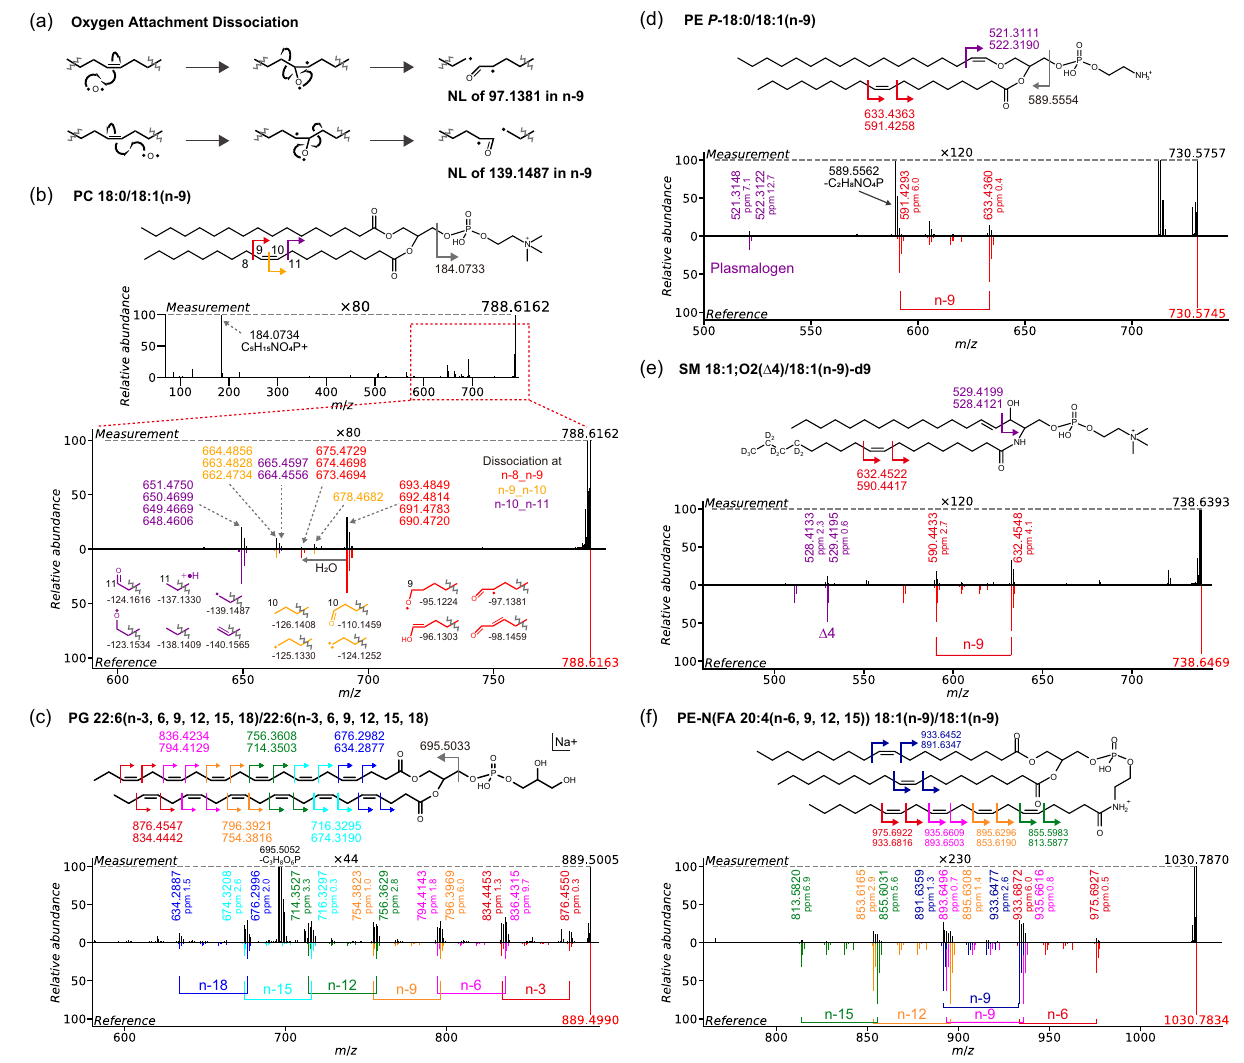
Fig. 1 Overview of the oxygen attachment dissociation (OAD) mass fragmentation scheme with authentic lipid standards. a Two major schemes of OAD. Neutral loss values are presented in case of n-9. b The OAD coupled with tandem mass spectrometry (OAD-MS/MS) spectrum of PC 18:1/18:1(n-9) and putative substructures of the OAD fragment ions. Bond cleavages occur in three locations (red, yellow, and purple), and the m/z values of product ions are described by the red, yellow, and purple colors. c – f OAD-MS/MS spectra of ( c ) PG 22:6(n-3, 6, 9, 12, 15, 18)/22:6(n-3, 6, 9, 12, 15, 18), ( d ) PE P- 18:0/ 18:1(n-9), ( e ) SM 18:1( Δ 4);O2/18:1(n-9)-d9 and ( f ) PE-N(FA 20:4(n-6, 9, 12, 15)) 18:1(n-9)/18:1(n-9). The theoretical m/z values of product ions are described along with the chemical structure, while the experimental m/z values and the corresponding mass accuracies of ppm are shown in the line chart of MS/MS spectrum. In the reversible spectral charts, the top and bottom panels show the experimental and reference MS/MS spectra,